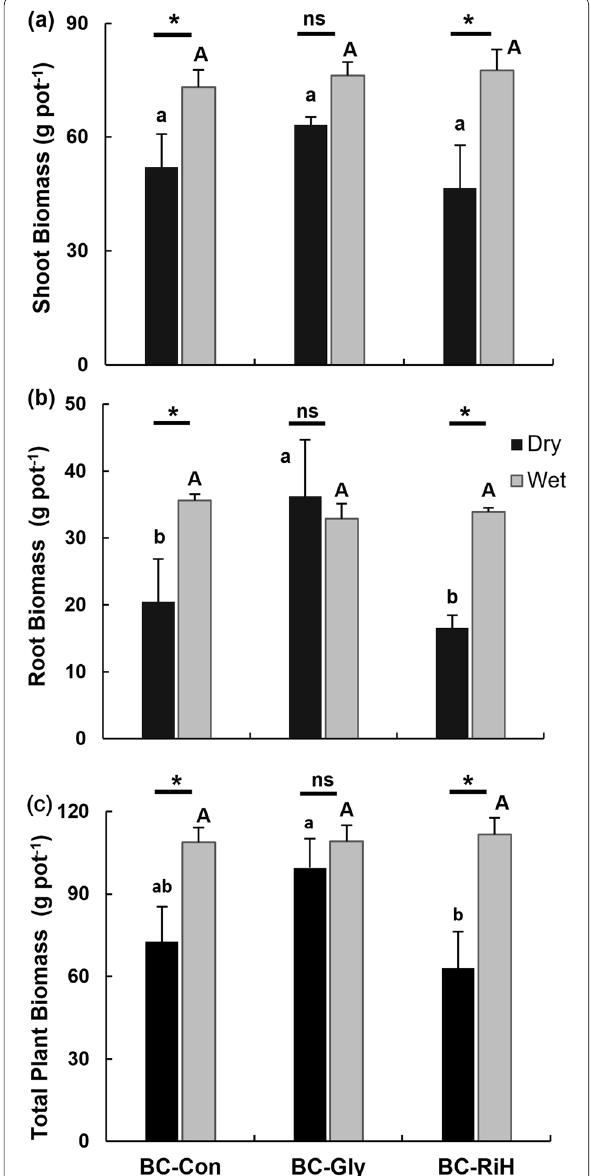
Fig. 2 Effect of biochar on coconut seedling growth under dry and wet moisture conditions. a Shoot biomass. b Root biomass. c Total plant biomass given in grams of dry matter per pot. Different lowercase and capital letters indicate significantly different biomasses (One-way ANOVA and LSD; p 0.05) between biochar treatments ≤ for the dry and wet moisture conditions, respectively. Asterisks indicate statistically significant differences (independent samples t -test, p 0.05) between dry and wet moisture conditions within ≤ each biochar treatment; ns- indicates ‘not significant’. Vertical bars represent standard errors of the means (n =